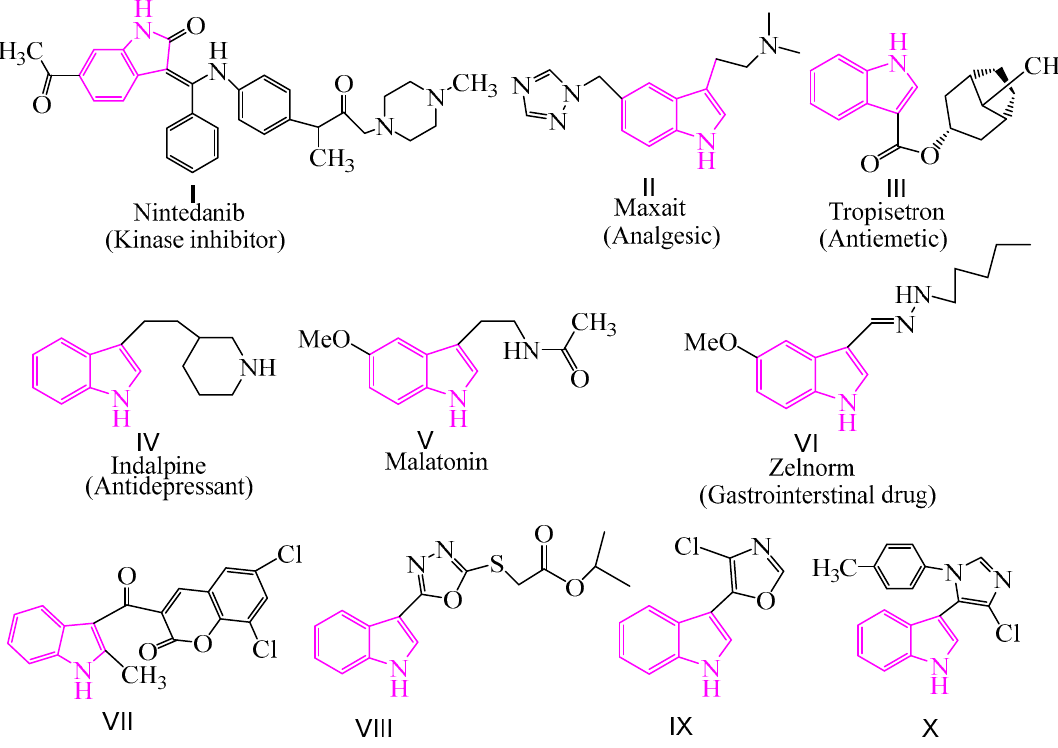
Figure 1. The structures of commercial drugs and antifungal active compounds containing indole.